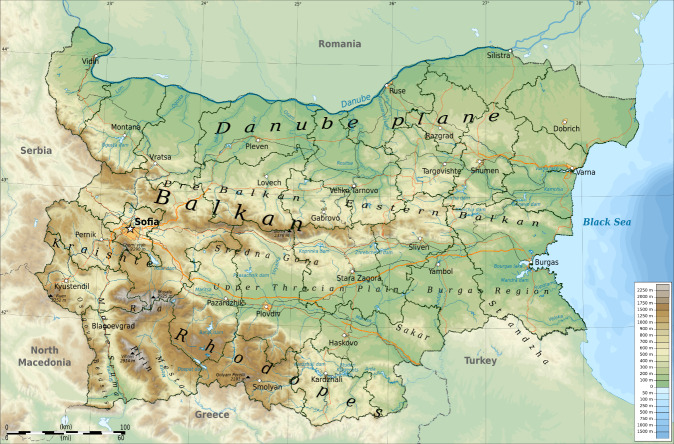
Geographic map of Bulgaria with the main geographical units and marked borders of the provinces and capitals. Source of the map Ikonact (2013).